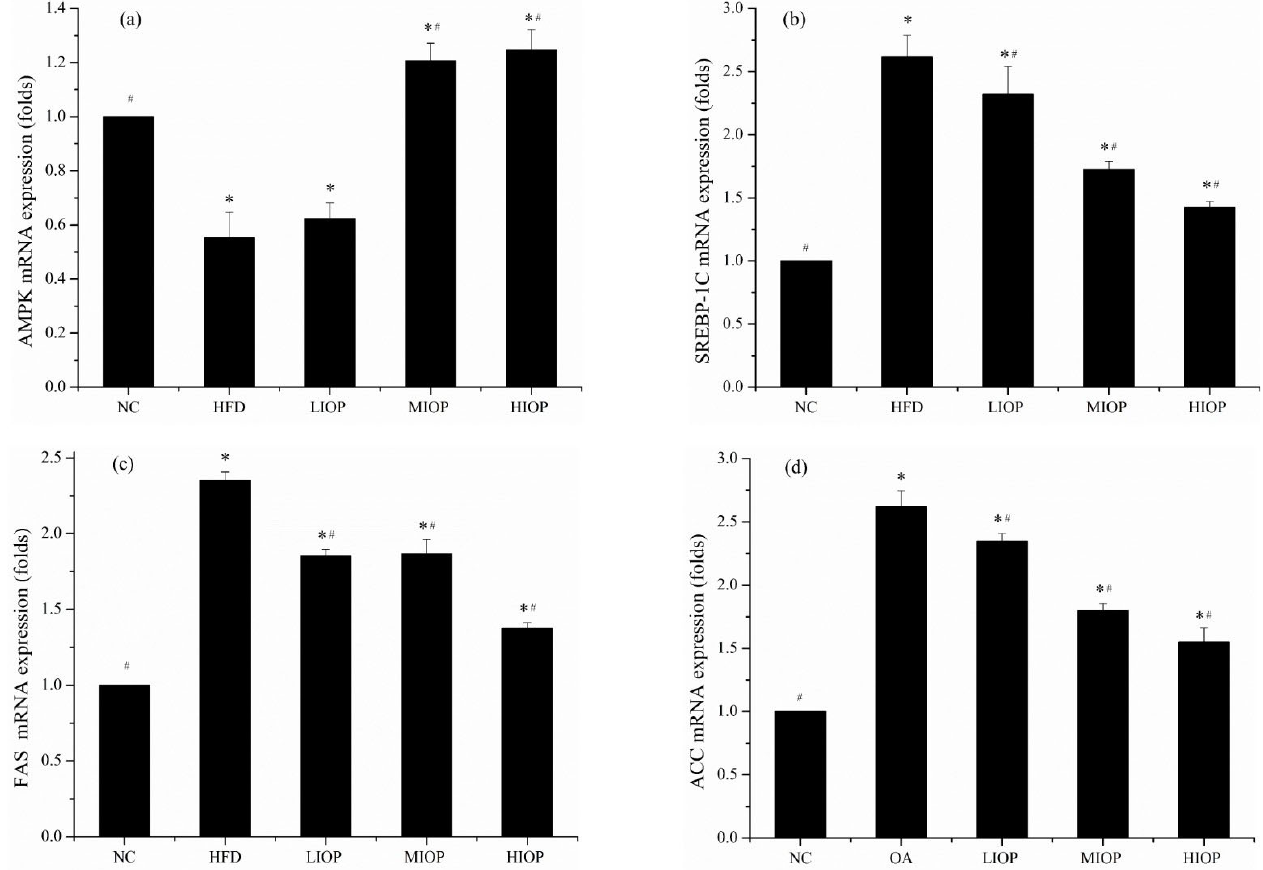
Figure 7. Effect of IOP on mRNA expression of mice livers. ( a ) AMPK; ( b ) SREBP-1C, ( c ) FAS; ( d ) ACC. Each value repre ‐ sents the mean of eight mice, and error bars indicate the standard deviation (±SD). * p < 0.05, versus the NC group; # p < 0.05, versus the HFD group.